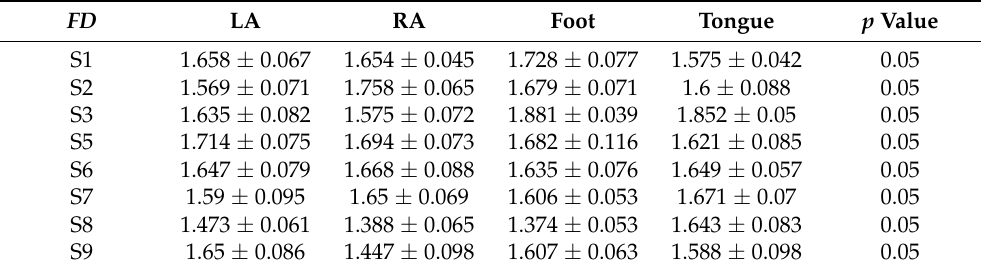
Table 4. The average values (mean ± SD) of FD to estimate the MI-BCI performance from four classes (left hand, right hand, feet, and tongue) of eight subjects individually. FD LA RA Foot